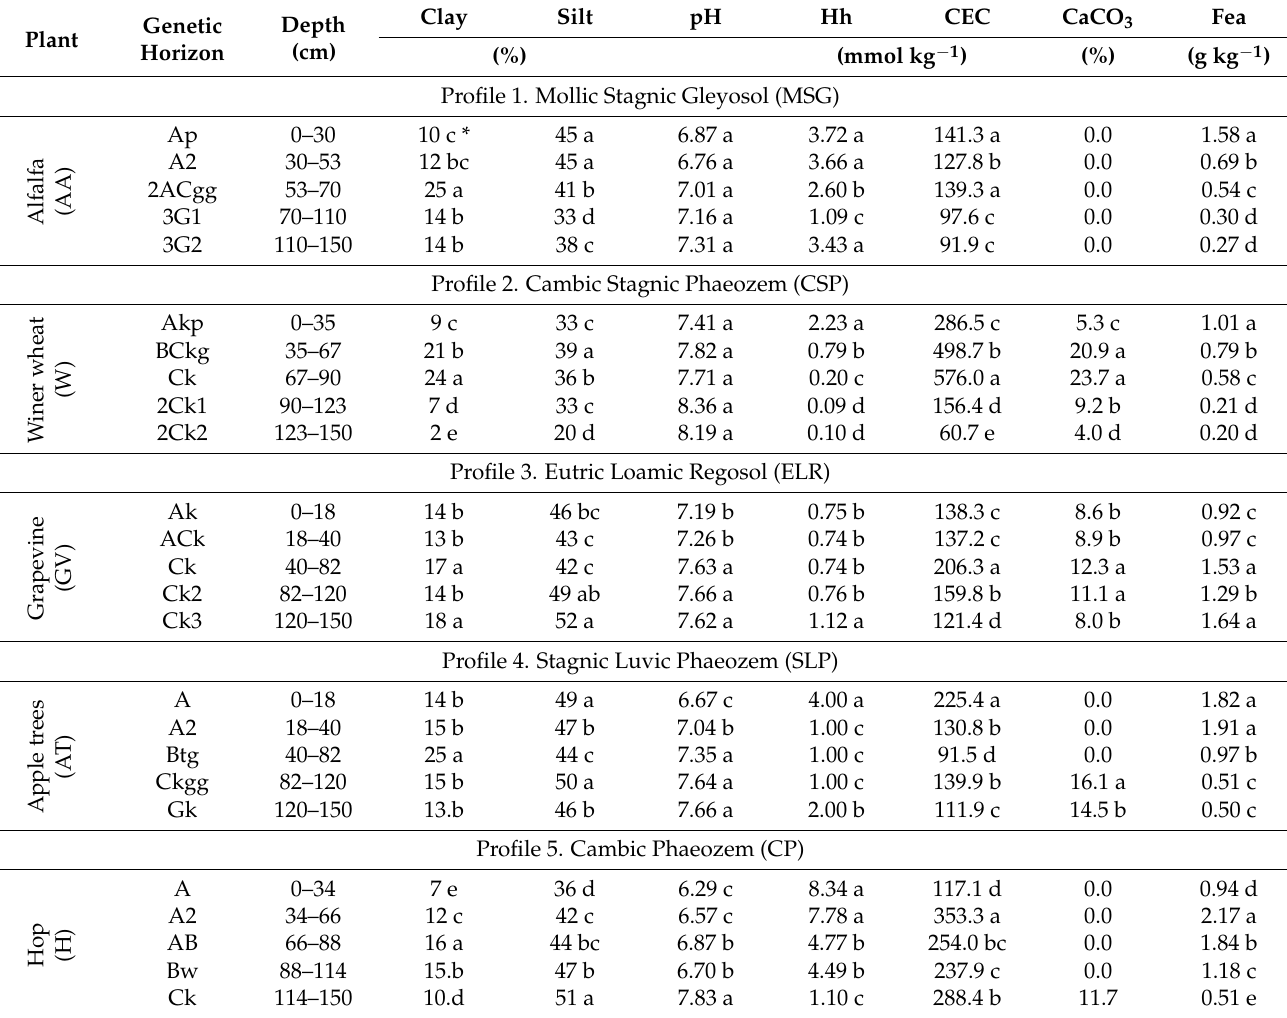
Table 1. Depth distribution of selected physico-chemical